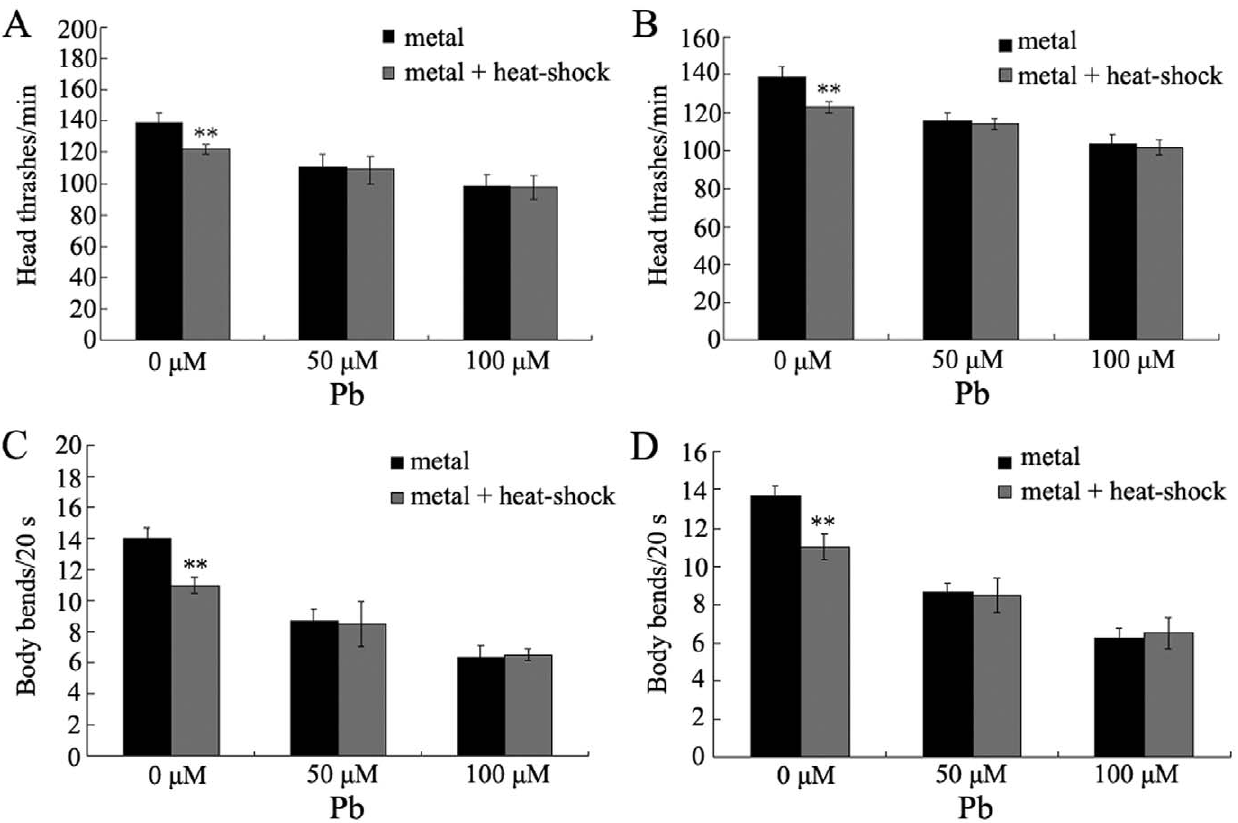
Figure 6. Effects of pre-treatment with mild heat-shock on neurobehavioral toxicity in Pb exposed mtl-1(tm1770) and mtl-2(gk125) mutant nematodes. (A) Effects of pre-treatment with mild heat-shock on head thrash in Pb exposed mtl-1(tm1770) mutant nematodes. (B) Effects of pre-treatment with mild heat-shock on head thrash in Pb exposed mtl-2(gk125) mutant nematodes. (C) Effects of pre-treatment with mild heat- shock on body bend in Pb exposed mtl-1(tm1770) mutant nematodes. (D) Effects of pre-treatment with mild heat-shock on body bend in Pb exposed mtl-2(gk125) mutant nematodes. L2-stage larvae animals were heat stressed for 1 h at 36 u C. The exposed metal concentrations were 50 and 100 m M. Bars represent means 6 S.D. ** p , 0.01 vs metal.